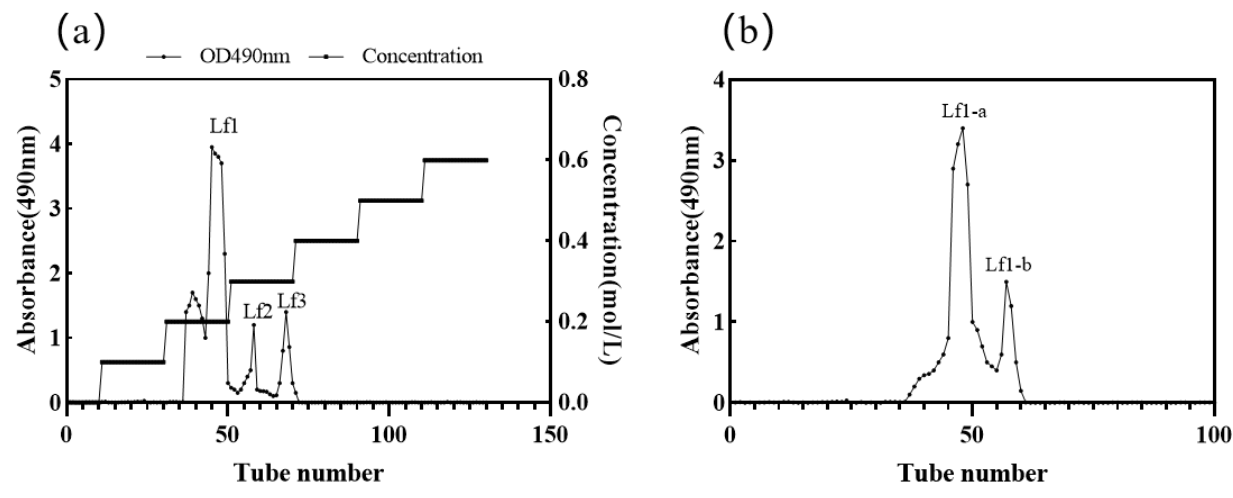
Figure 4. Chromatography purification of TEPS: ( a ) TEPS fraction of Lf1, Lf2, and Lf3 using stepwise elution on DEAE-Sepharose FF column (20 mm × 100 cm, 1.25 mL/min); ( b ) Lf1-a and Lf1-b TEPS from Lf1 subsequently obtained on Sephacryl S100 column (10 mm × 60 cm, 0.5 mL/min).